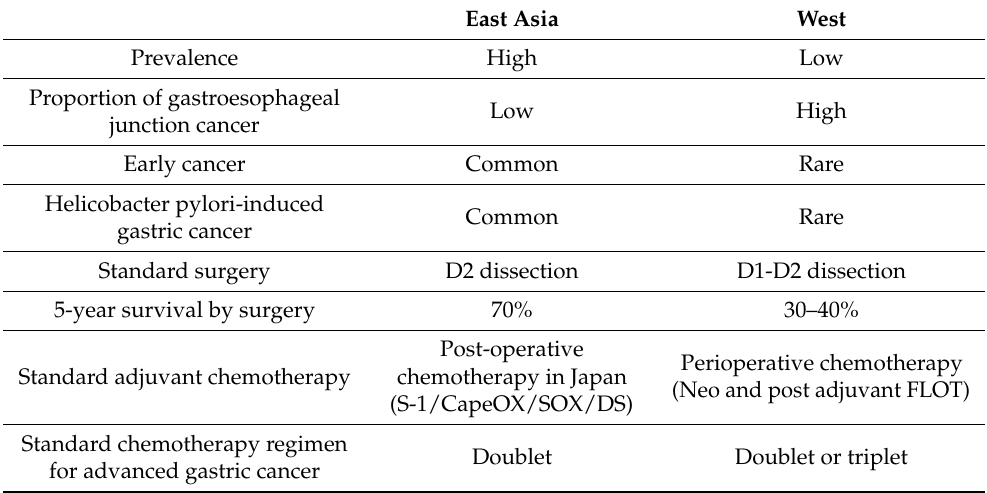
Table 1. Comparison between the East and West gastric cancer.